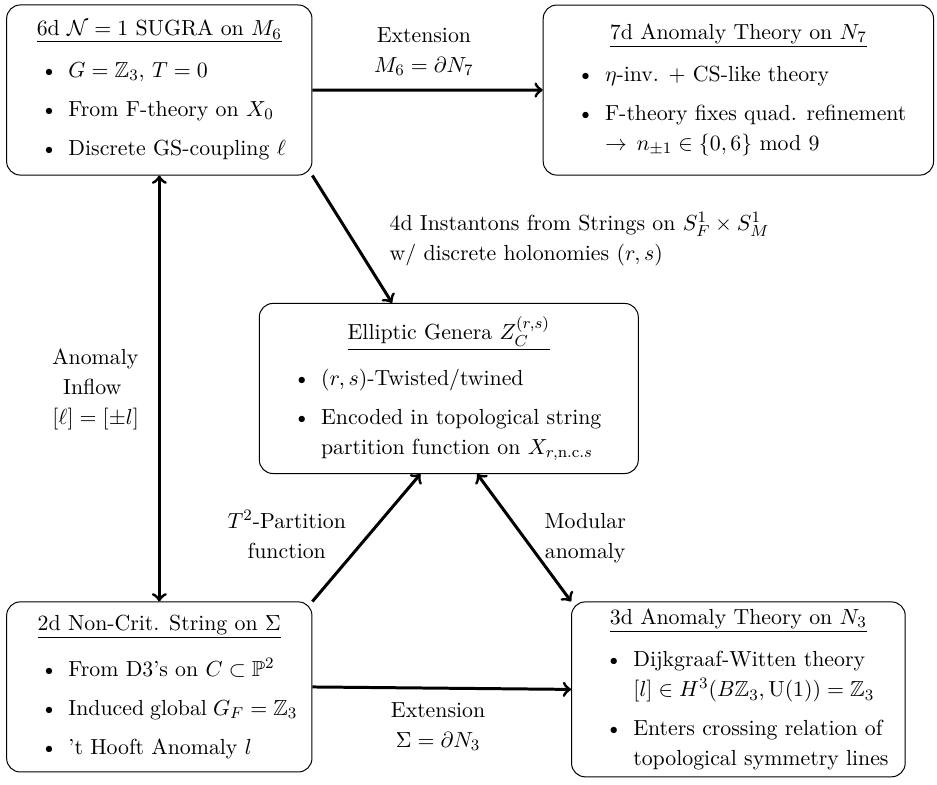
Figure 1 . The relationship between the different theories and objects that enter our